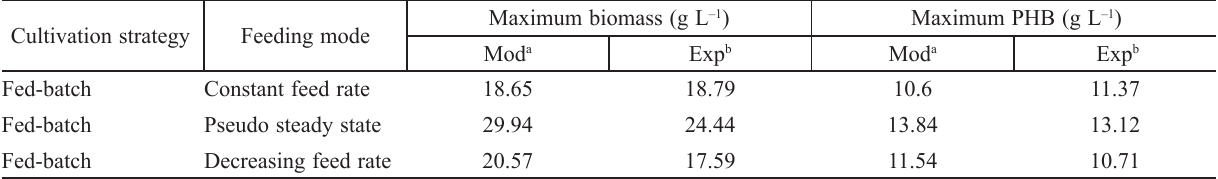
Mod a – model predicted values, Exp b – results of experimental